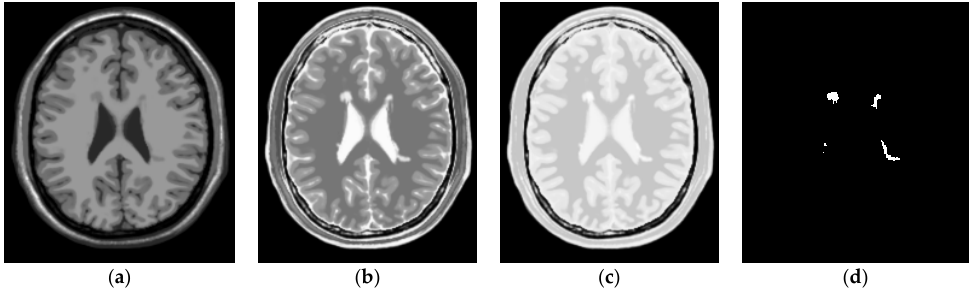
Figure 4. Three MR images containing MS lesions acquired by T1W, T2W and PD with 0% noise and 0% INU. ( a ) T1W; ( b ) T2W; ( c ) PD; ( d ) ground truth (lesions) Table 1. Specifications of parameters used by NBE-ICEM for BrainWeb images. Band images T1W, T2W, PD (3